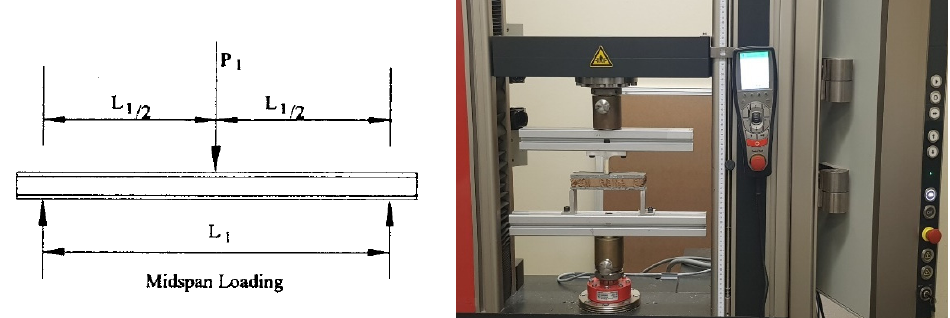
Figure 3. The flexural-strength-testing setup of the honeycomb sandwich